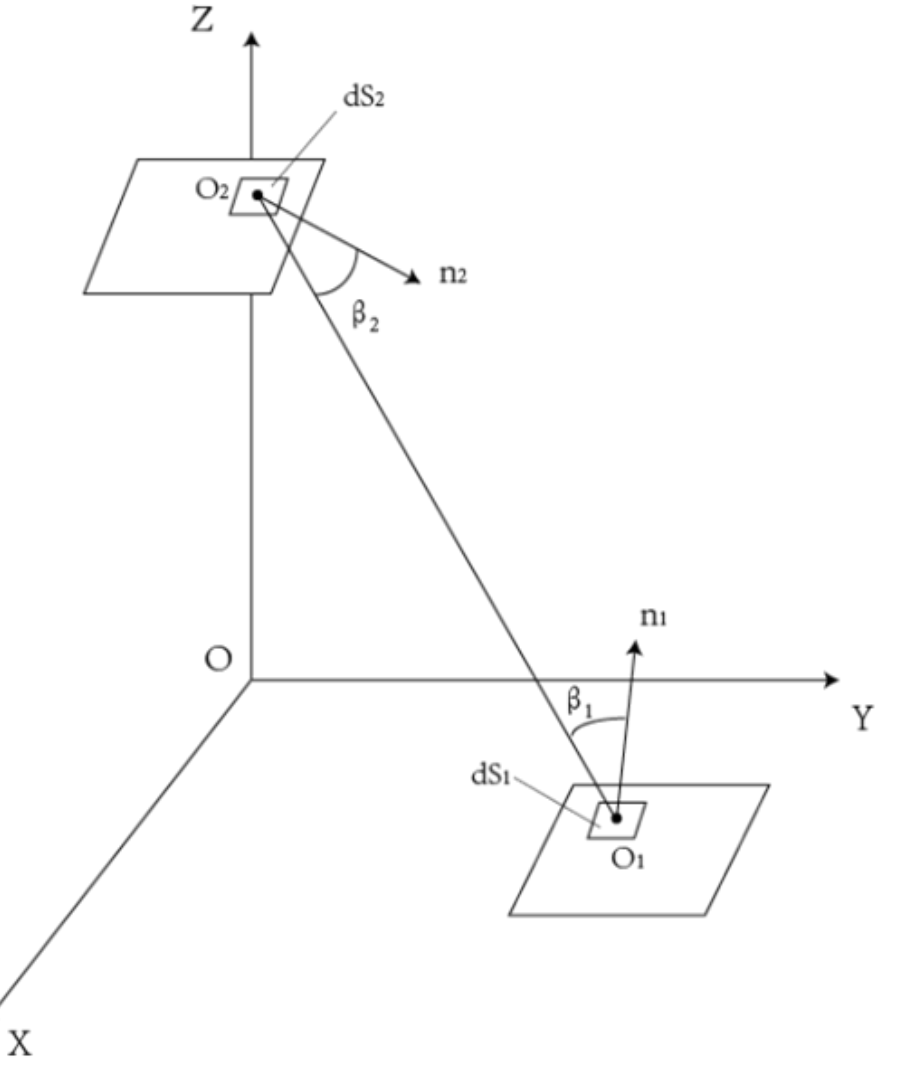
Figure 3. X axis points due east, Y axis points due north, and Z axis points